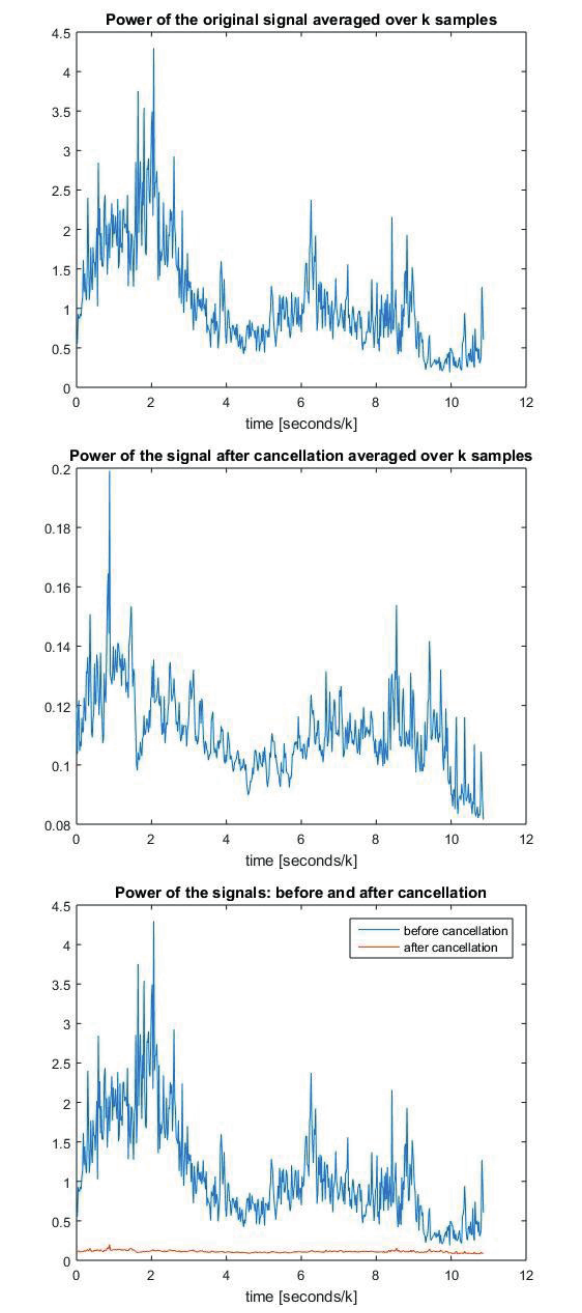
Fig. 7: Illustration of power before and after cancellation, for an example of infra-sound noise signal. Power calculated every 2 sec-